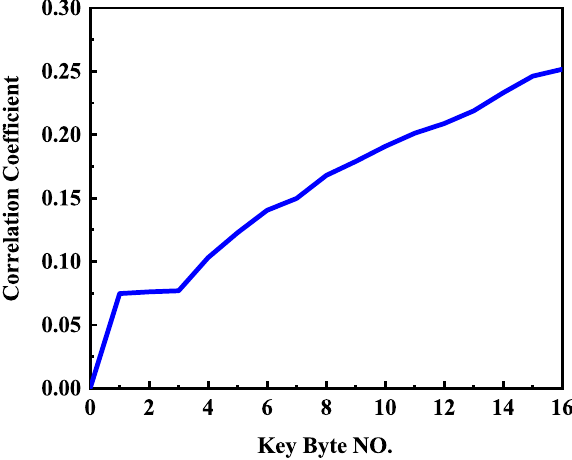
Figure 9. The relationship between correlation and multiple key bytes. Figure 10 demonstrates the performance of different methods. The performance of PSO-CEMA is best and CEMA is much better than DEMA. For PSO-CEMA, the number of electromagnetic traces is approximately 4500 when the secret key is recovered correctly. With the same number of traces, CEMA’s success rate is approximately 70%, which still needs more traces. When PSO-CEMA and CEMA recover the key correctly, the success rate of DEMA is very low. It still needs a large number of traces if we want to get the right key. The reason is that, in DEMA, only a single bit is used, the other 127 bits are regarded as noise. As a result, little useful information can be used in DEMA. Thus, in the latter, we didn’t take DEMA into account because of its low efficiency.